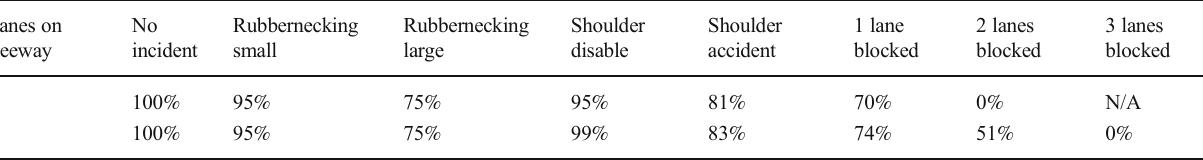
Table 5 Utilisation of remaining capacity Lanes on